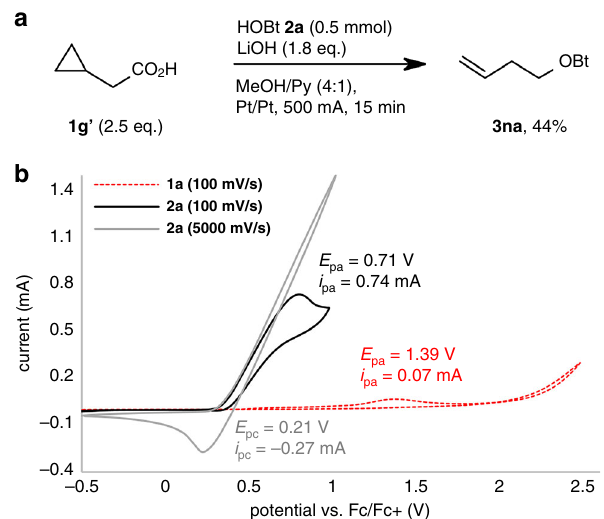
Fig. 4 Mechanistic insights. a Radical clock experiment. b Cyclic voltammetry of hydrocinnamic acid ( 1a ) and HOBt ( 2a ). Voltammograms recorded in 100 mM solutions of analyte with ( n -Bu) 4 NPF 6 or ( n -Bu) 4 NBF 4 (100 mM) in MeOH/pyridine (4:1). Starting potential: − 0.5 V; Pt disk (2 mm diameter, working electrode); Pt wire (counter electrode); Ag/Ag + redox couple (reference electrode). Potential scale calibrated against external ferrocene/ferrocenium 75 . Red dotted line: hydrocinnamic acid 1a (100 mV s − 1 ); black line: HOBt 2a (100 mV s − 1 ); grey line: HOBt 2a